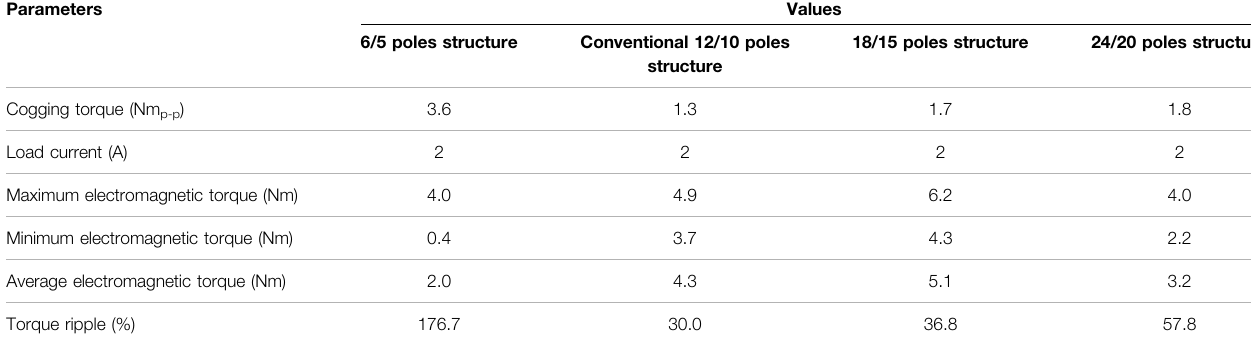
TABLE 2 | Torque pro fi les of the proposed DSPM structures.